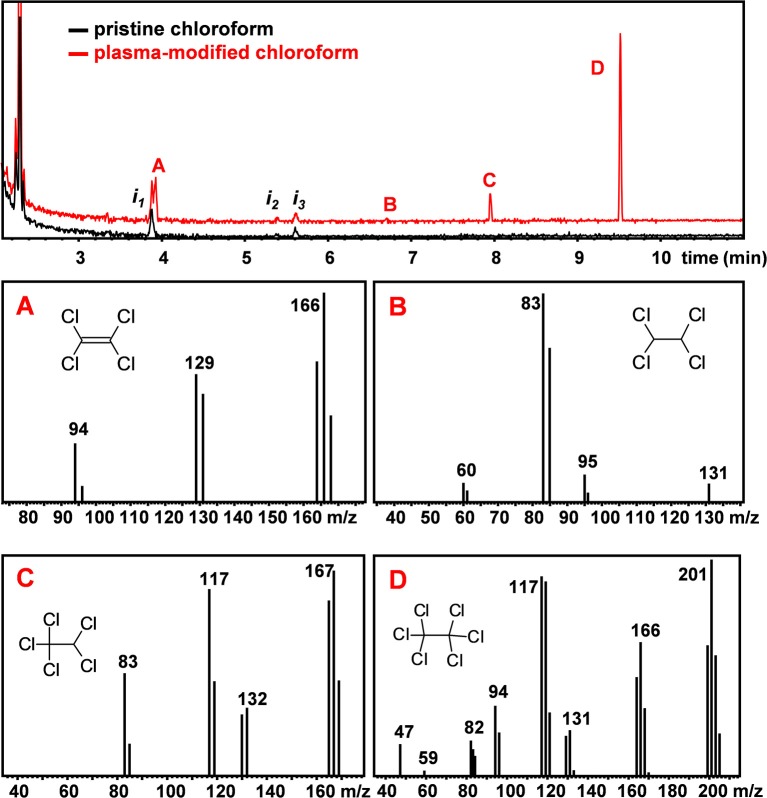
GC-MS chromatogram of pristine (black) and plasma-treated (red) CHCl3. MS spectra of peaks A to D. The labeled peaks were identified to be (A): tetrachloroethylene (C2Cl4), (B) 1,1,2,2-tetrachloroethane (C2H2Cl4), (C) pentachloroethane (C2HCl5) and (D) hexachloroethane (C2Cl6).